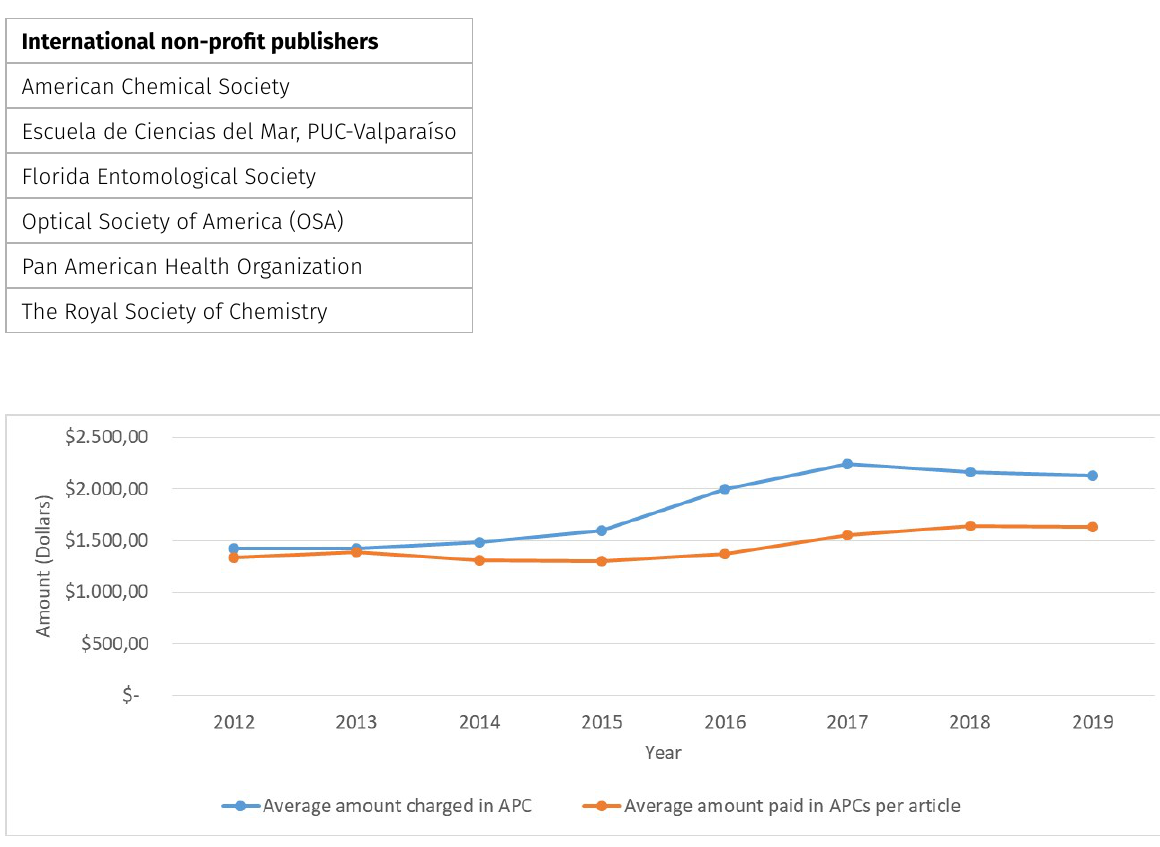
Figure 4. Average APC cost amount and average APC amount paid per article from journals maintained by commercial publishers in the 2012-2019 period (Source: the authors).